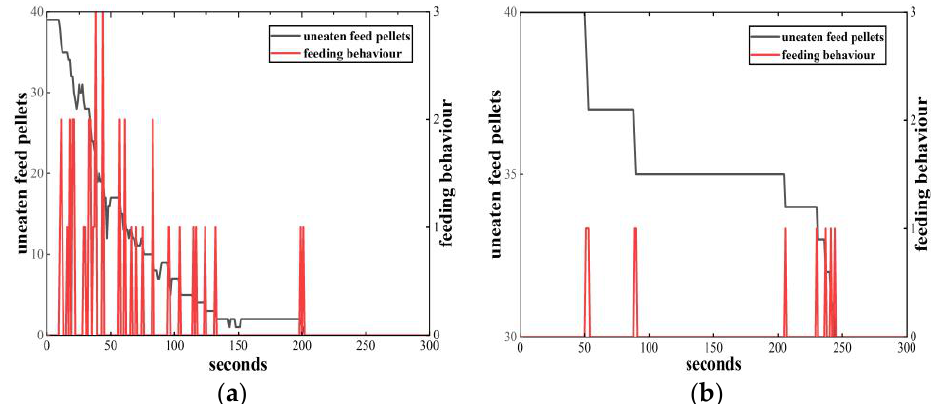
Figure 5. The relationship between fry feeding behaviors and uneaten pellets: ( a ) fry feeding in high intensity; ( b ) fry feeding in low intensity.